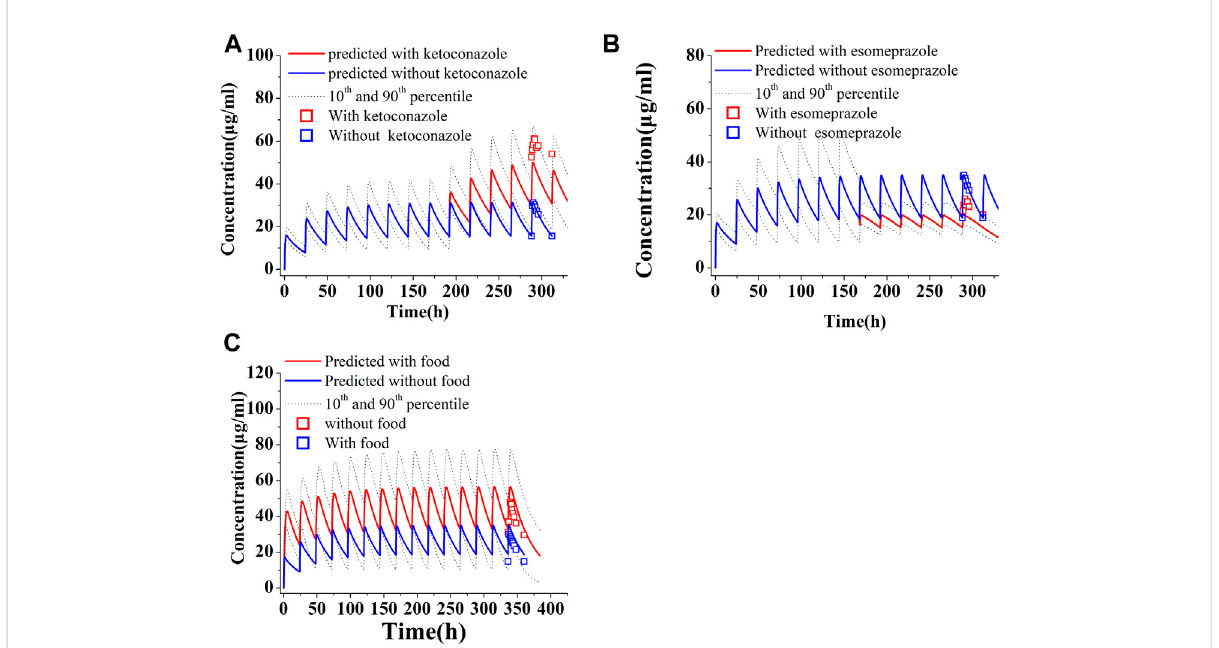
FIGURE 5 SimulationsofpharmacokineticsofPAZunderdifferentsituations. (A) PAZ400 mgODwas fi rstadministeredfor7 days,thenco-administration ofPAZplusketoconazole(400 mgOD)wasgivenforanother5 days. (B) PAZ800 mgODwasadministeredfor7days,thenco-administrationofPAZ plus esomeprazole (40 mg OD) was given for another 5 days. (C) Co-administration of PAZ 800 mg OD with food were simulated for consecutive 14 days. The blue squares ( □ ) refer to clinically measured values without ketoconazole (A) , esomeprazole (B) and food (C) . The red squares ( □ ) refer to clinically measured values with ketoconazole (A) , esomeprazole (B) and food (C) .